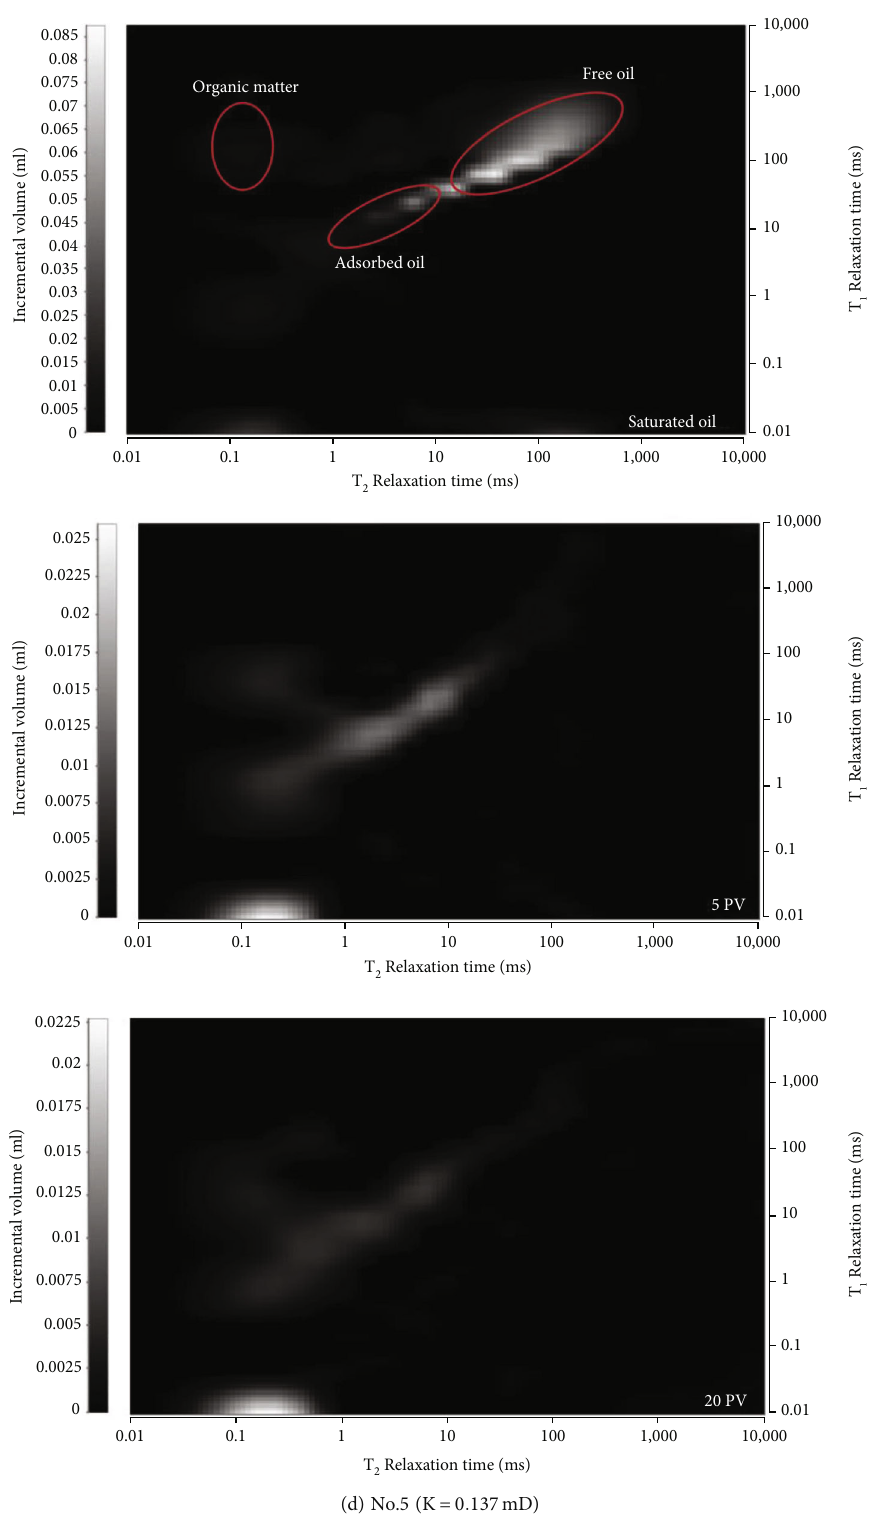
(d) No.5 ( K = 0 : 137mD ) Figure 5: T -T 2D NMR spectra of parallel rock samples at di ff erent displacement 1 2